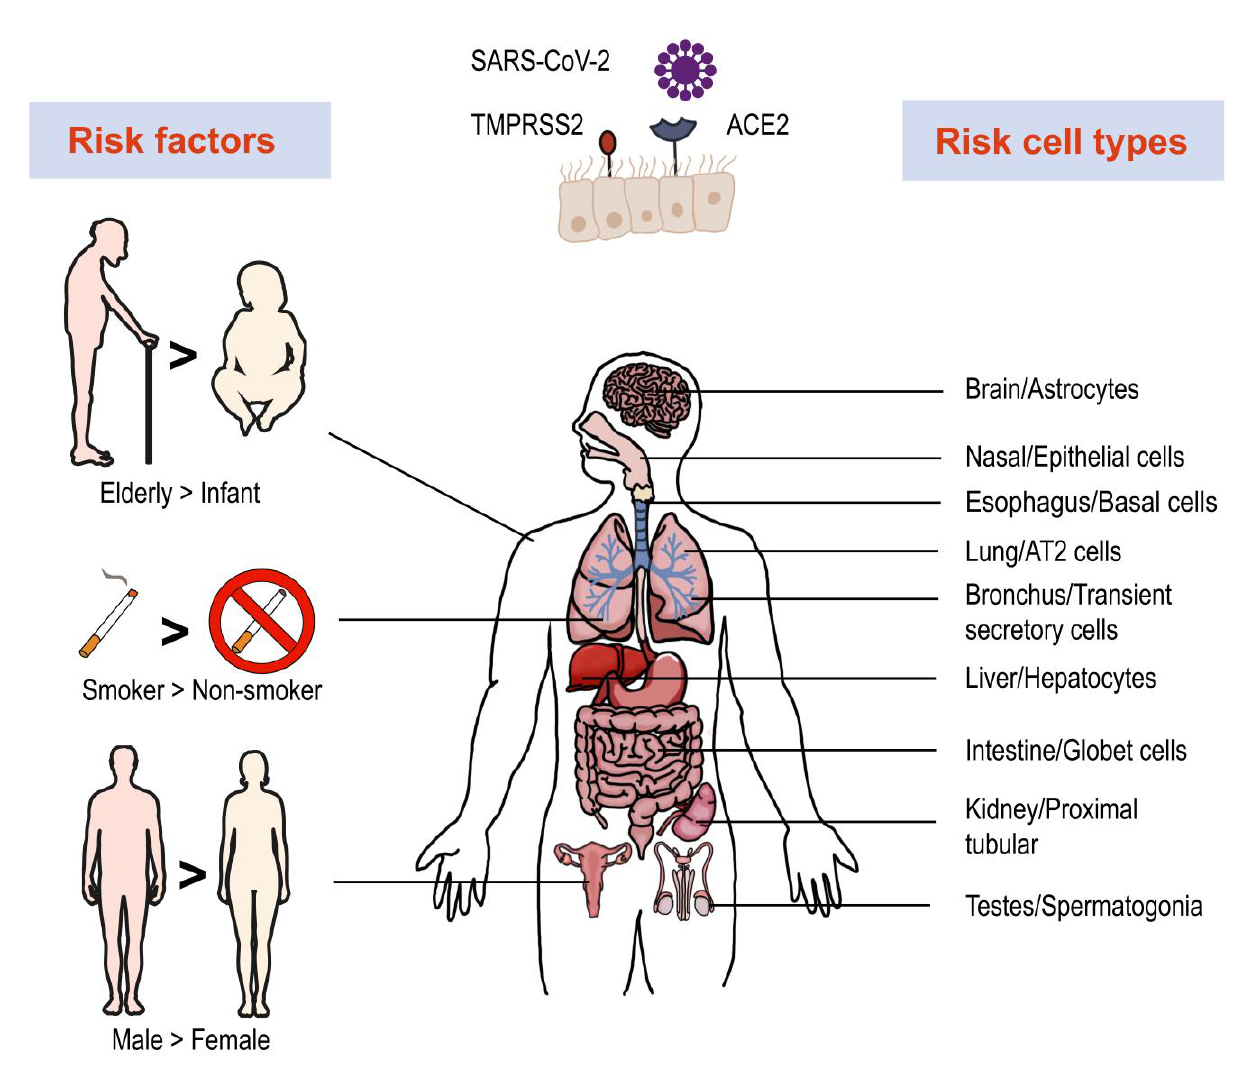
FIGURE 1: Risk factors, vulnerable organs and cell types involved in SARS-Cov-2 infection. Single-cell RNA-seq revealed high expression of ACE2 and TMPRSS2 in multiple organs and cell types, which are more vulnerable to SARS-Cov-2 infection. Several factors play important roles in infection and disease process, such as age, smoking and